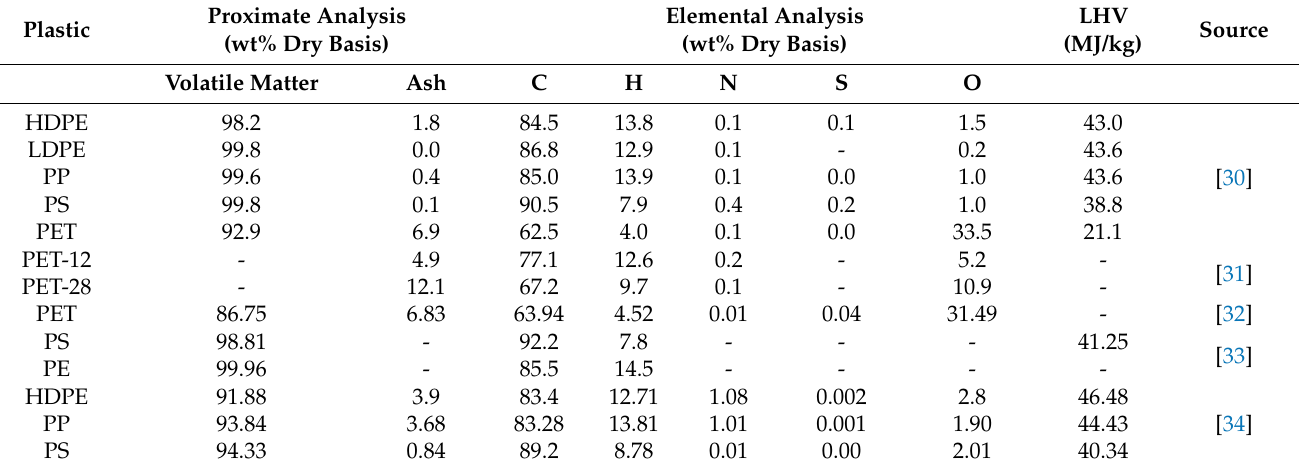
Table 1. Proximate and ultimate analysis of plastic